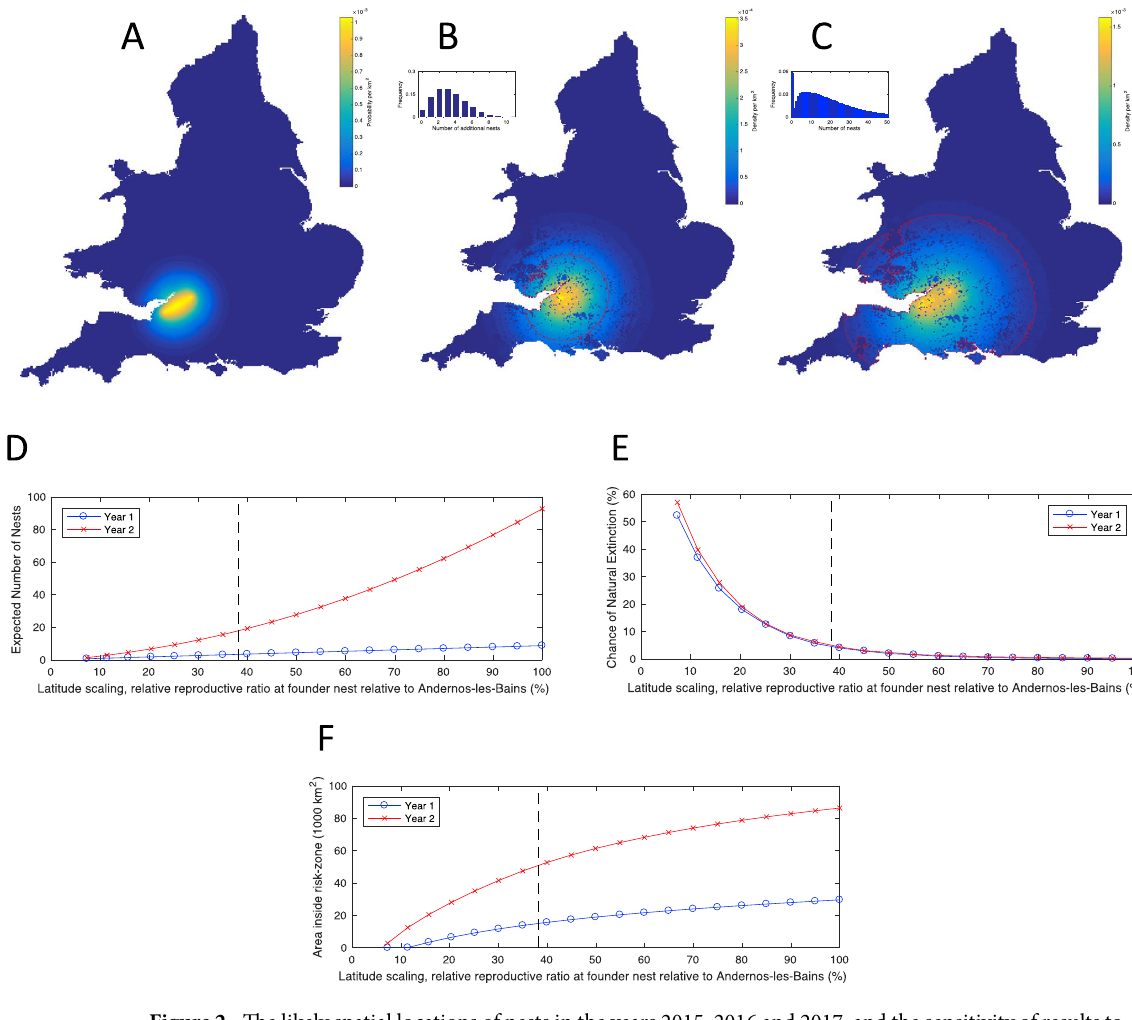
Figure 2. The likely spatial locations of nests in the years 2015, 2016 and 2017, and the sensitivity of results to the effect of latitude-on the numbers of nests. Given the two locations in which a nest and a hornet were found in 2016, map ( A ) shows the most likely positions of a common ancestor nest in 2015. Extrapolating forward from this probable location, maps ( B and C ) show the likely density of undiscovered nests in 2016 and new nests in 2017 respectively. The red contour is defined such that outside this (high-risk) region we would expect to find less than one nest. The inset histograms show the likely distribution of nests in each year, accounting for parameter uncertainty and stochastic variability. Graphs ( D – F ) explore the sensitivity of these findings to our assumption about the effects of latitude; in particular, we vary the linear function of latitude and plot on the x-axis the realised reproductive ratio at the likely location of the founder nest in 2015 relative to that inferred from the Andernos-les-Bains data (Supplementary Material). We show the expected number of nests ( D ), the chance that the invasion naturally dies out ( E ) and the area within the high-risk red contour ( F ) – blue lines correspond to Year 1 (2016), red lines to Year 2 (2017). (All results are calculated explicitly from the probabilistic rates in the Supplementary Material without having to use stochastic simulations. Maps are generated from EEA Corine Land Cover data 28 and displayed with bespoke software using Matlab 29